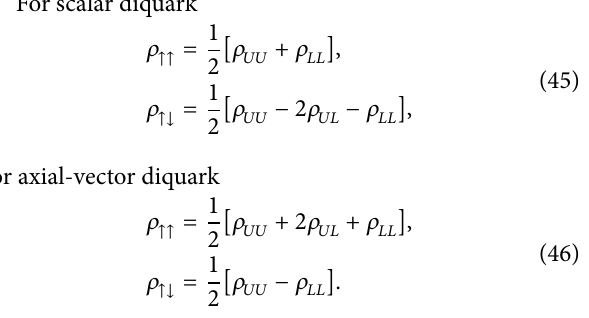
Figure 3: The plot of Wigner distribution 휌 (left panel) and 𝑑 -quark (right